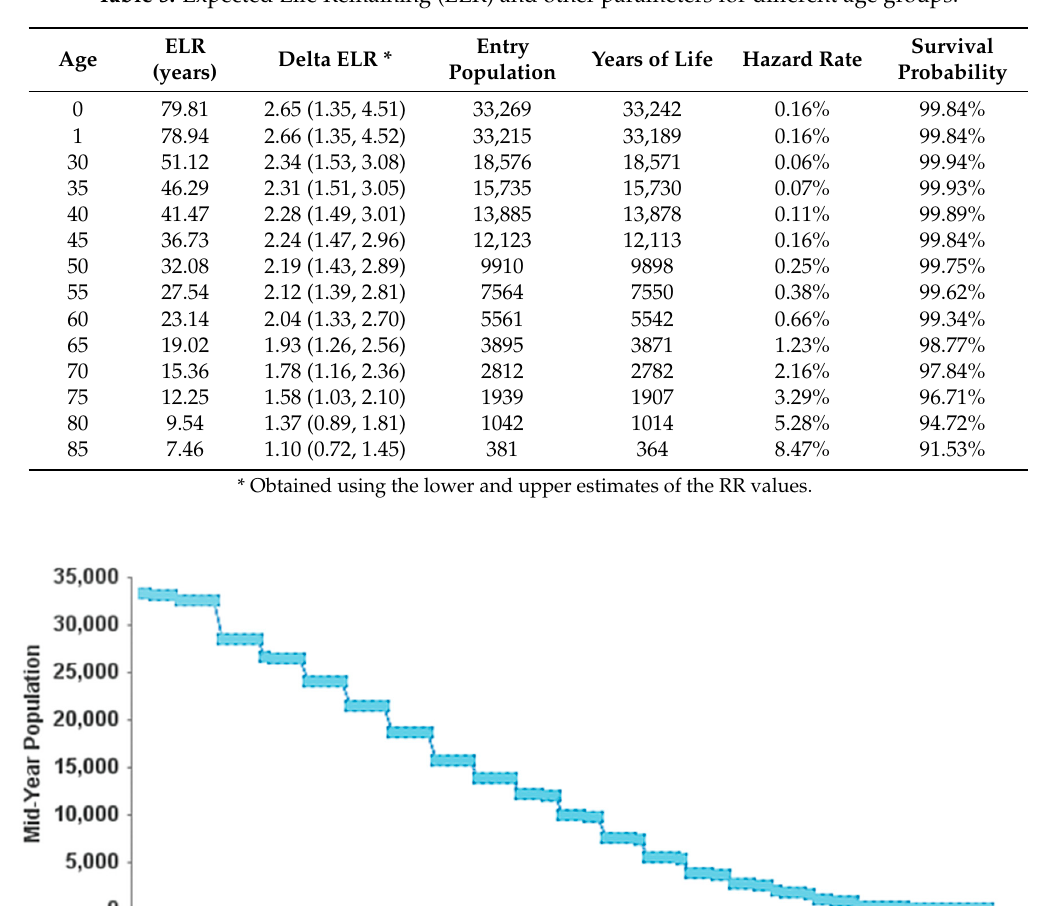
Table 5. Expected Life Remaining (ELR) and other parameters for different age groups.